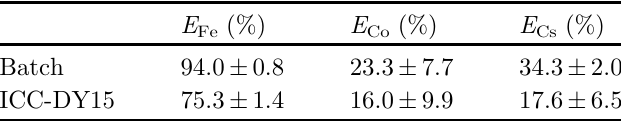
Table 2. Selectivity of extraction of Fe, Co and Cs in batch experiment and in a ICC-DY15